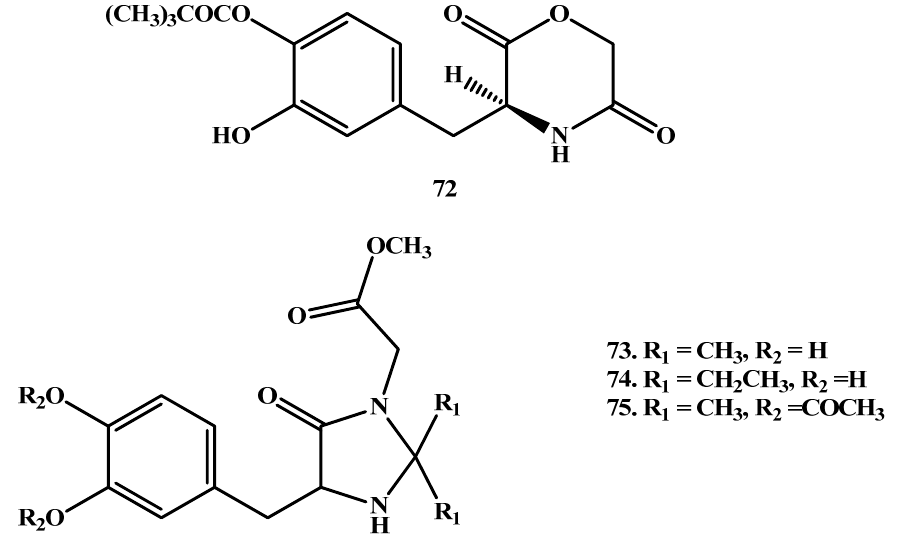
Figure 13. Chemical structures of cyclic prodrugs of LD, 73 – 75 .